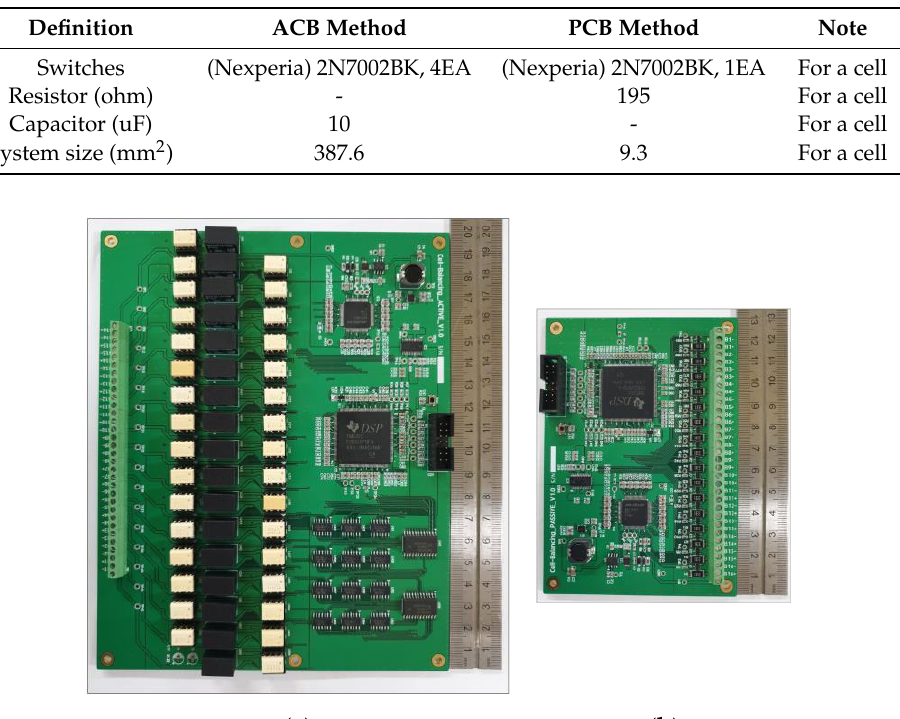
Figure 8. Experimental cell-balancing circuit prototype: ( a ) the ACB circuit; ( b ) the PCB circuit.